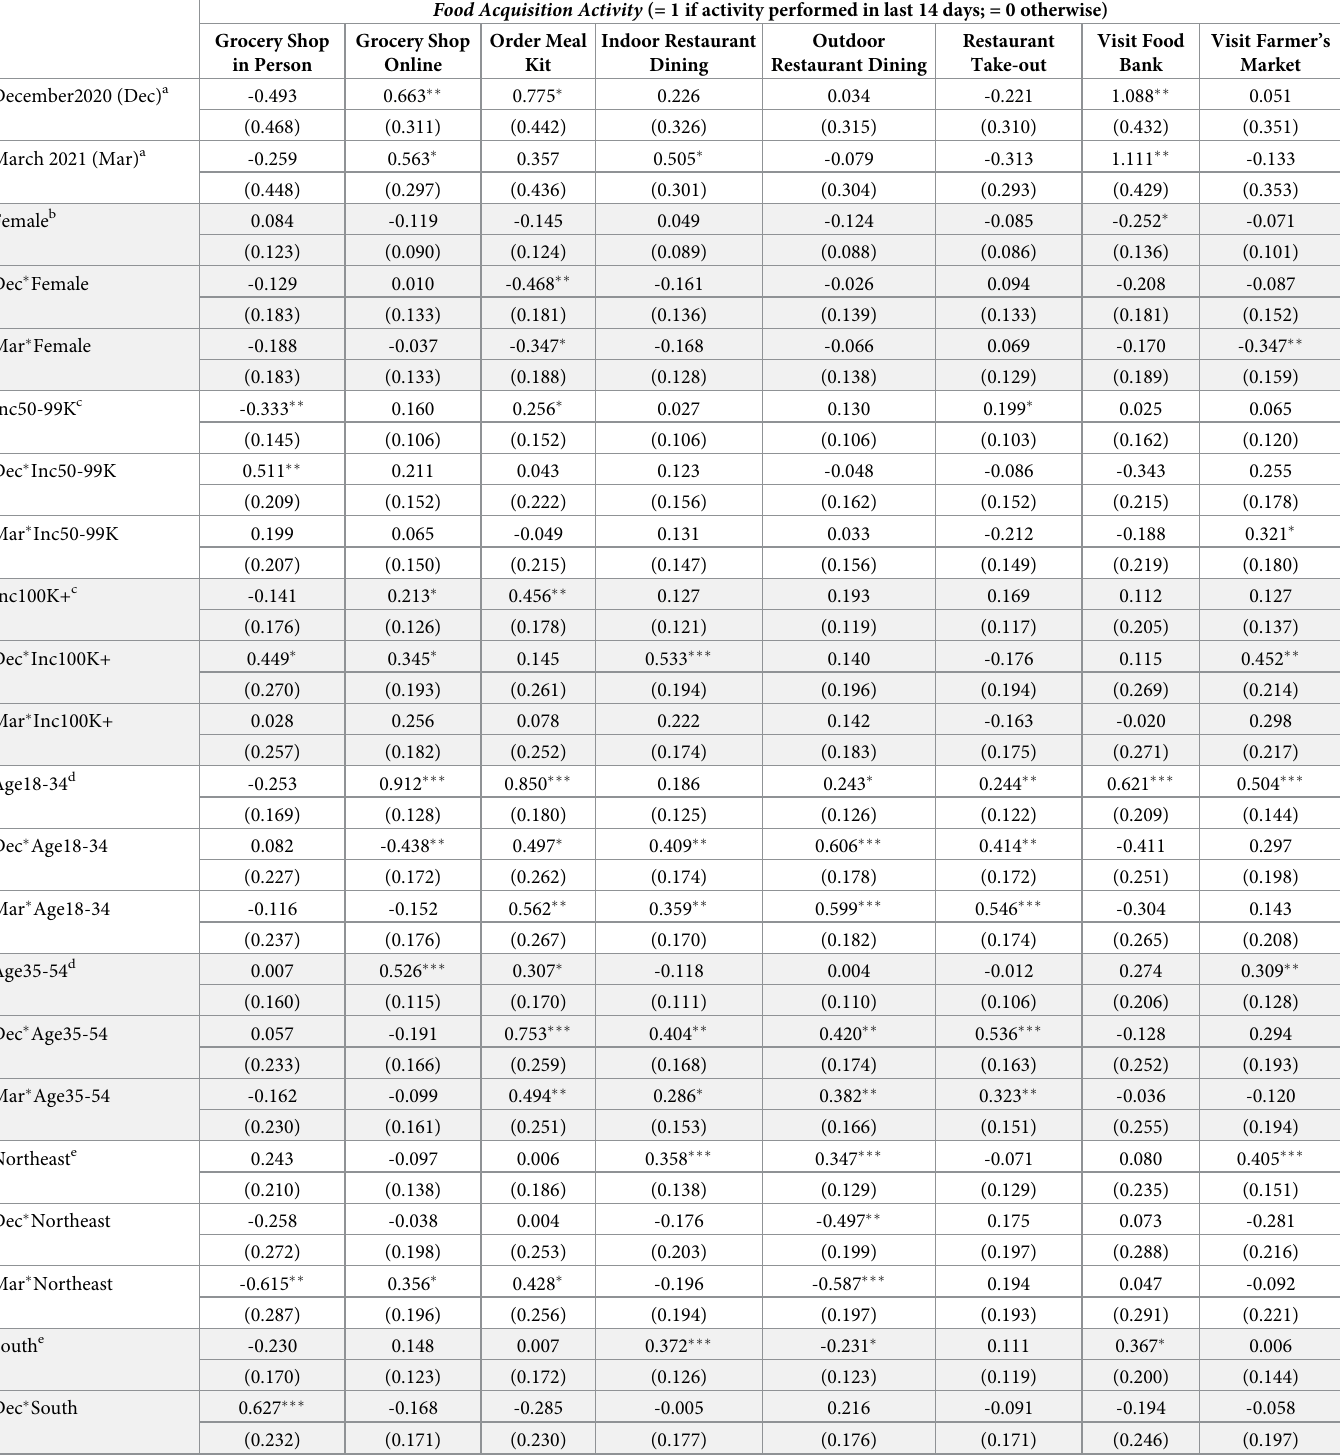
Table 2. Multivariate probit estimation results for eight food acquisition